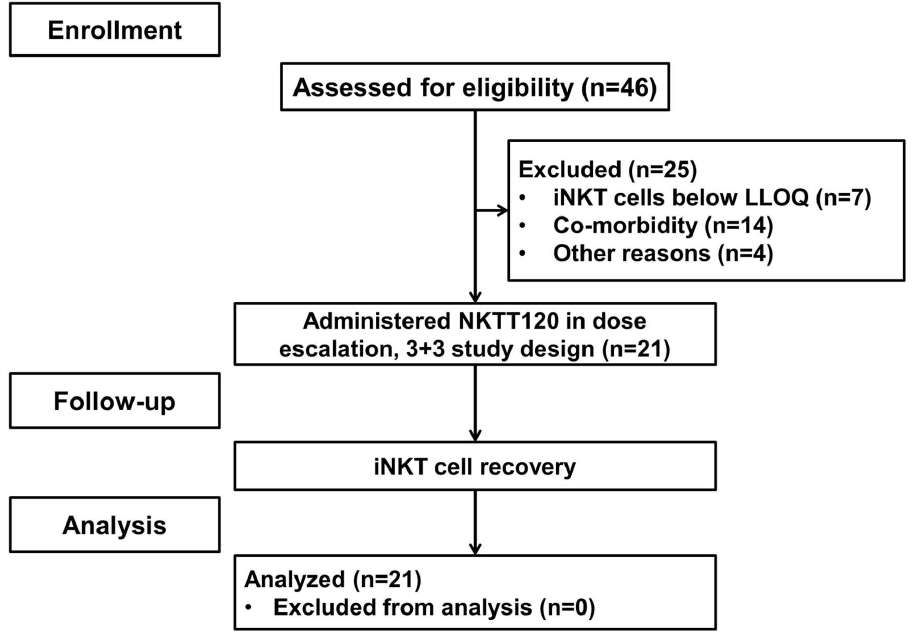
Fig 1. Subject flow through